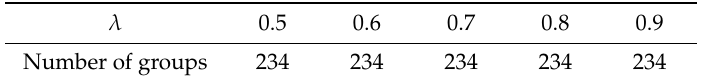
Table 3. The relationship between λ and the number of groups (orange leaves